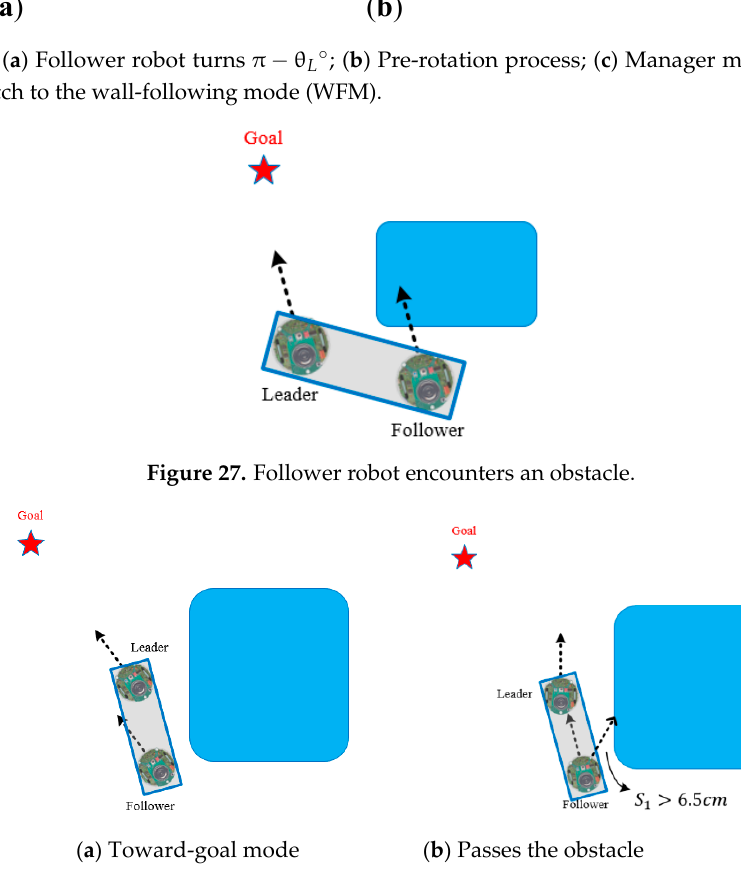
Figure 28. Object on the two robots passes the obstacle.